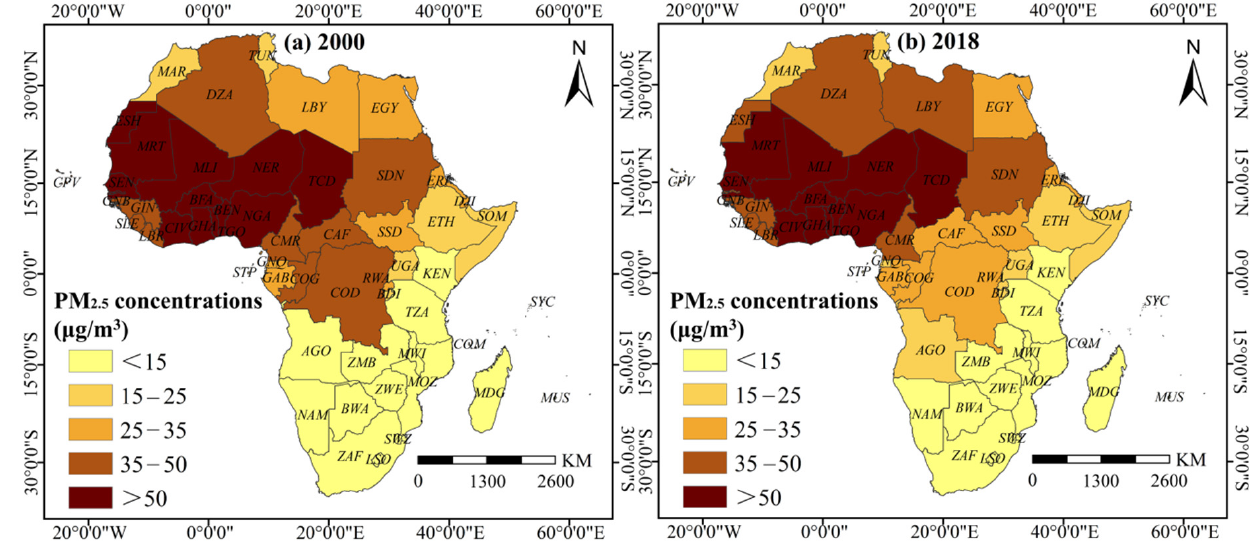
Figure 3. Spatial pattern of PM 2.5 concentrations in African countries in 2000 and 2018. The results also showed that the levels of population agglomeration, land expansion, and economic construction exhibited varying degrees of spatial heterogeneity. (1) Popu- lation agglomeration (Figure 4): from 2000 to 2018, the mean population agglomeration level in African countries increased by 44.1%. Among them, Eastern Africa had the highest population agglomeration average level and fastest growth rate, which the population density increased to 149 persons/km 2 and a growth rate of 44.4% from 2000 to 2018. (2) Land expansion (Figure 5): from 2000 to 2018, the mean land expansion level among African countries increased by 54.7%. By 2018, the high value areas were concentrated in Northern and Southern Africa and in the coastal countries along the Gulf of Guinea. In 2018, the impervious surface coverage (ISC) in Northern Africa was 0.0031, and 0.0027 in the Southern African region, representing an increase of 47.5% and 35.08%, respectively. The countries with the highest ISC included Mauritius, Ghana, Tunisia, South Africa, Egypt, and Nigeria, with values exceeding 0.0053. (3) Economic construction (Figure 6): from 2000 to 2018, the mean economic construction level among African countries increased by 359%, of which Central and Western Africa increased the most, with 1051.9% and 314.4%, respectively. High-value clusters formed gradually across the Central Region, from Uganda to Senegal. Other high-value areas can also be found in Northern Africa (Tunisia, Morocco, Egypt) and Southern Africa (South Africa, Lesotho, Swaziland).